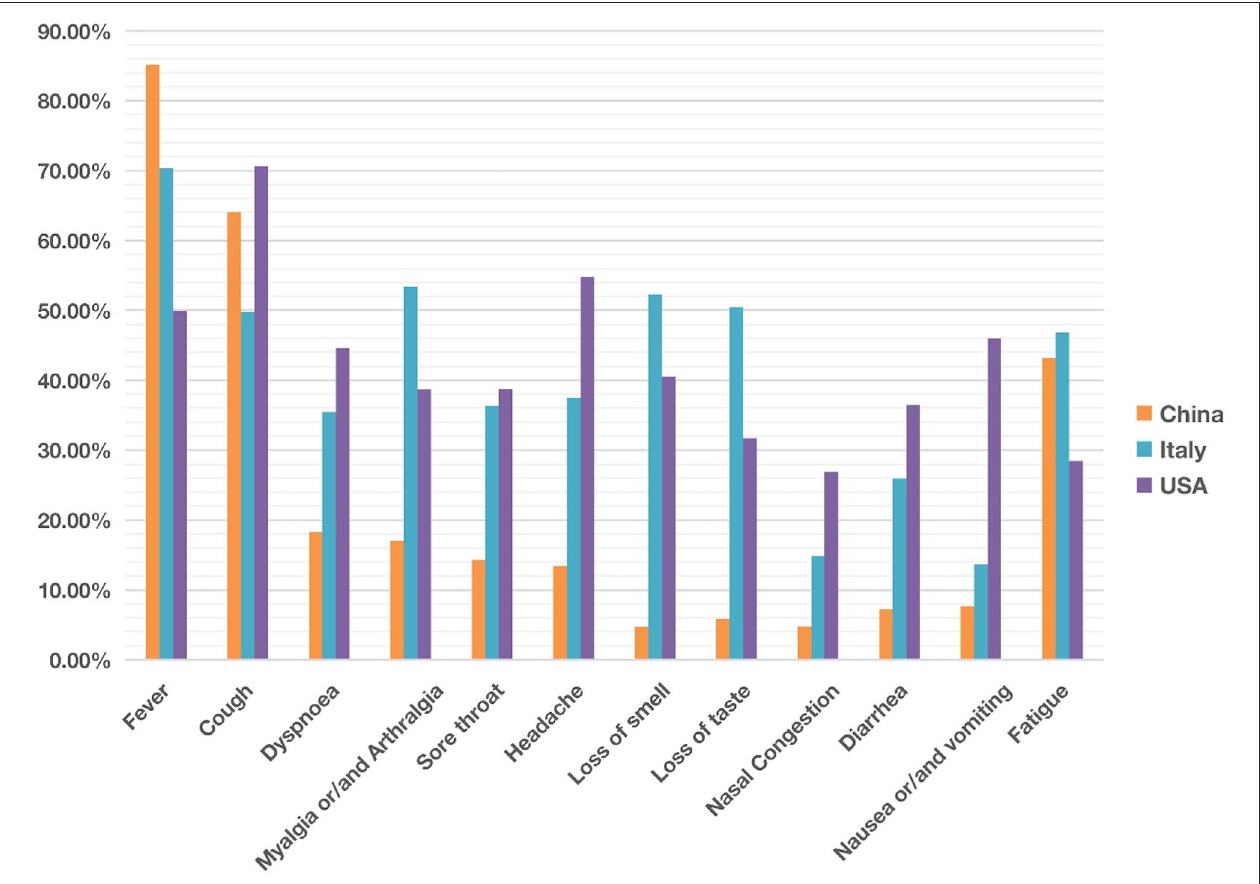
FIGURE 2 | Comparison of common clinical symptoms of COVID-19 between China, Italy and the United States from December 2019 to May 2020. China was ranked the highest in fever, The USA was ranked the highest in cough, dyspnea, headache, diarrhea, and nausea/vomiting. Italy was ranked the highest